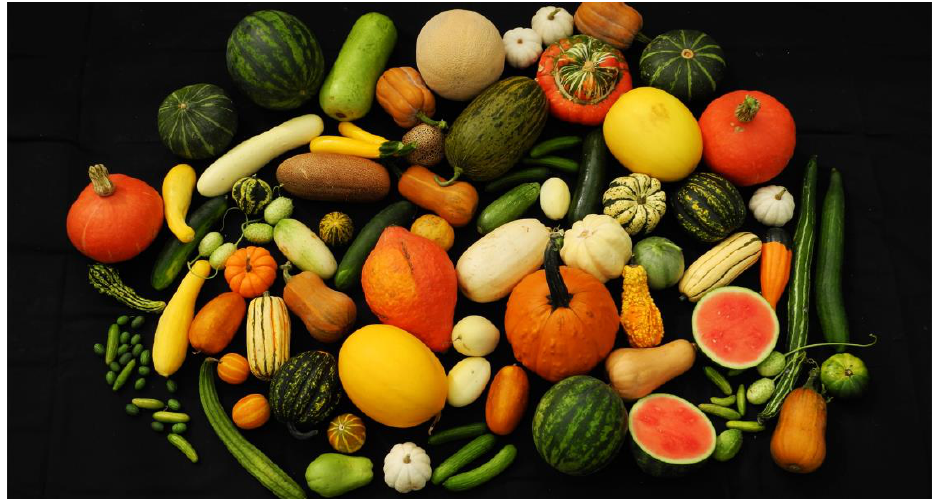
Figure 1. Cucurbit crops exhibit extensive diversity in fruit size, shape, and color. Production data for the predominant cucurbit crops are maintained by the Food and Agriculture Organization of the United Nations (FAO) (http://www.fao.org/faostat/en/#data/QC) (Accessed 10 March 2021) [2]. In 2019, worldwide cucurbit production included 100.4 Mt (megatonnes) for watermelon, 87.8 Mt for cucumber, 27.5 Mt for other melons, and 22.9 Mt for pumpkins and squashes (Table 1). While more than 100 countries (105–132) produce each of these crops in sufficient quantity to be recorded, in each case, the top 12 producing countries contribute greater than 70% of the global yield (ranging from 70.3% for pumpkins and squashes to 91.6% for cucumbers). China alone produces greater than one-third of worldwide production for each of these crops, contributing 36.7% of pumpkin and squash production; 49.1% of melons; 60.5% of watermelon; 80.1% of cucumber (Table 1, Figure 2). The other cucurbit crop recorded by the FAO is the melon seed (egusi), with a worldwide production of 1.0 Mt, of which 94% is produced in Africa, especially Nigeria with 60% of total production. Egusi seed can be produced from several different species, most commonly from Citrullus mucosospermus [3]. Table 1. Worldwide cucurbit crop production (Mtonnes) in 2019. Data are from the Food and Agriculture Organization of the United Nations, (http://www.fao.org/faostat/en/#data/QC) (Accessed 10 March 2021) [2]. Watermelon